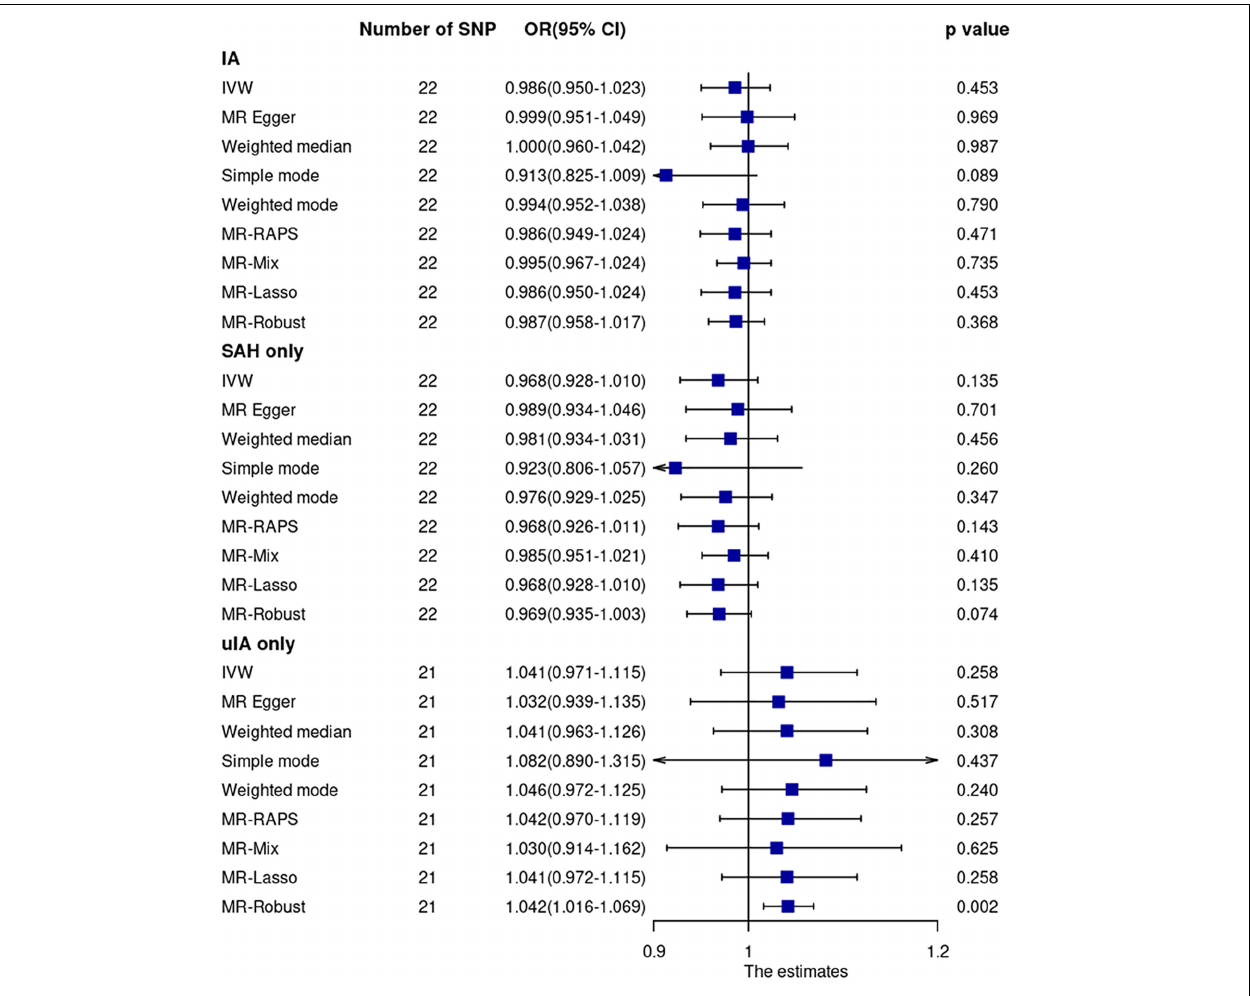
FIGURE 2 | Mendelian randomization analyses of sIL6R levels on risk of IA. CI, confidence interval; IVW, inverse variance weighted; OR, odds ratio; SAH, subarachnoid hemorrhage; SNP, single nucleotide polymorphism; uIA, unruptured intracranial